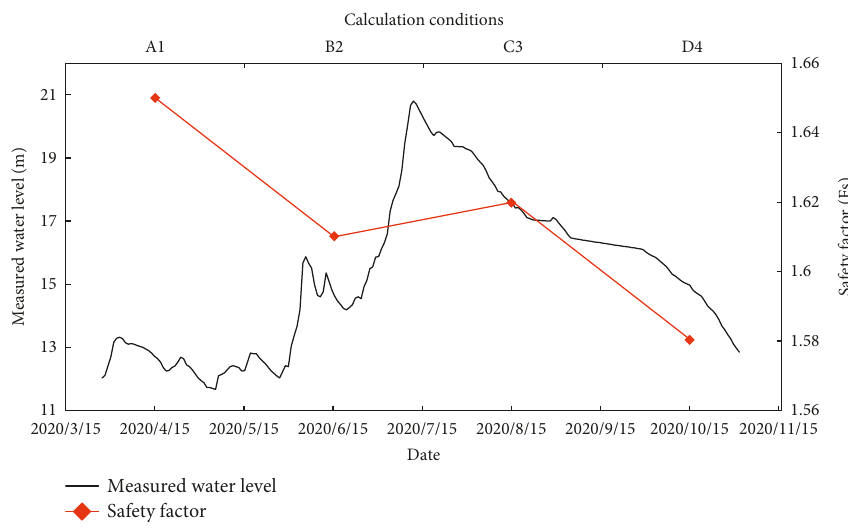
Figure 11: Variation of safety factors under different operating